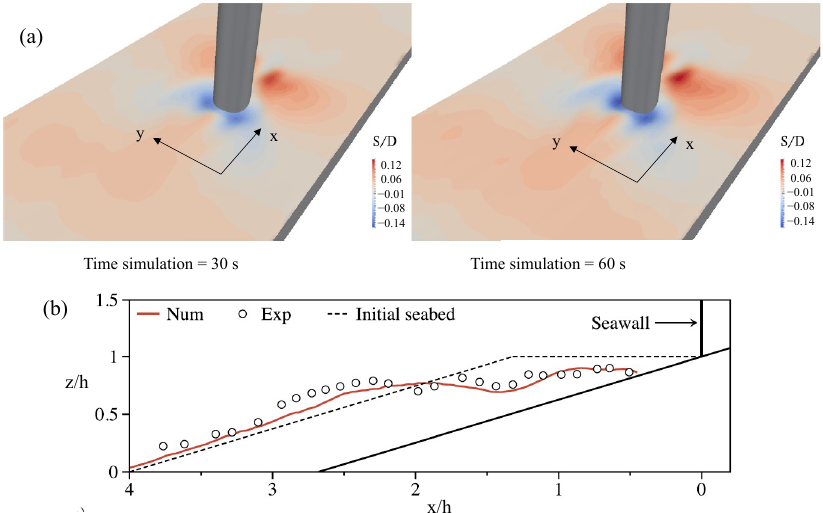
Figure 8. ( a ) Simulated scour profile ( S ) around a pile with diameter D induced by the wave action with normal direction to the structure (x-direction) (adapted from Ahmad et al. [69]); ( b ) simulated scour profile due to the wave breaking impact versus the experimental data of Hughes and Fowler [82] around a seawall (adapted from Ahmad et al.